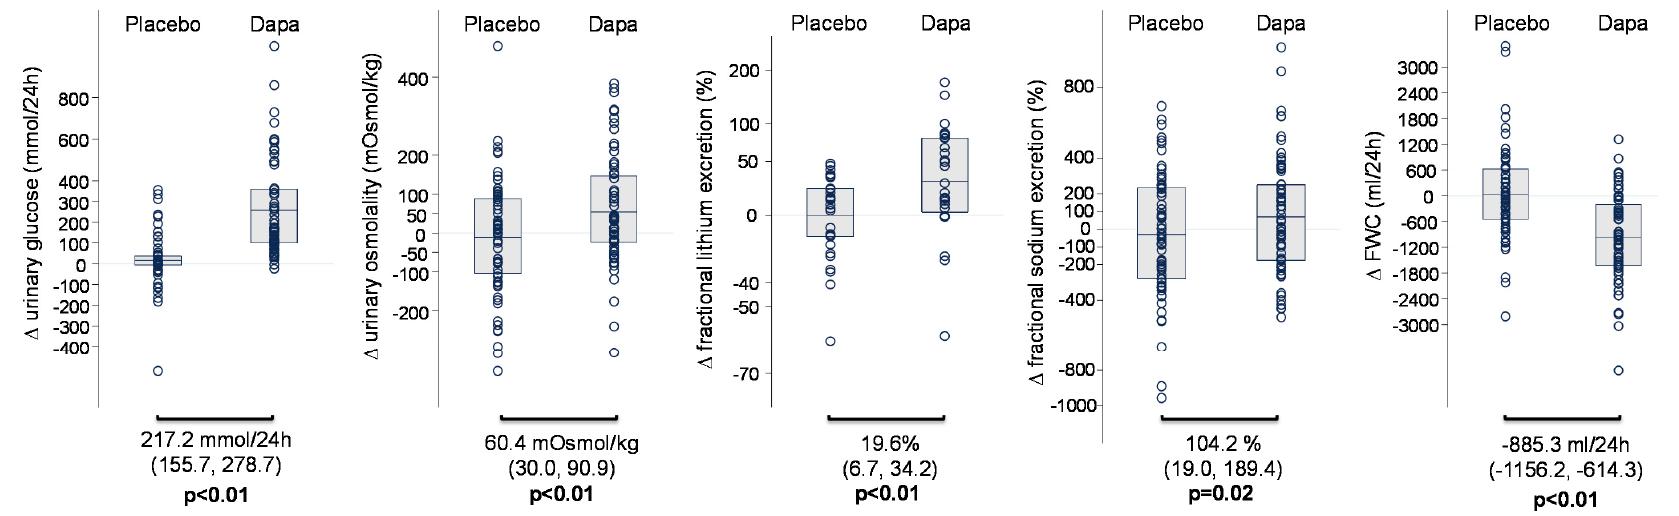
Figure 1. Volume markers at baseline, at the end of placebo treatment, at the end of dapagliflozin treatment, and changes in volume markers during dapagliflozin treatment versus placebo in the merged database (IMPROVE study and DapKid study).